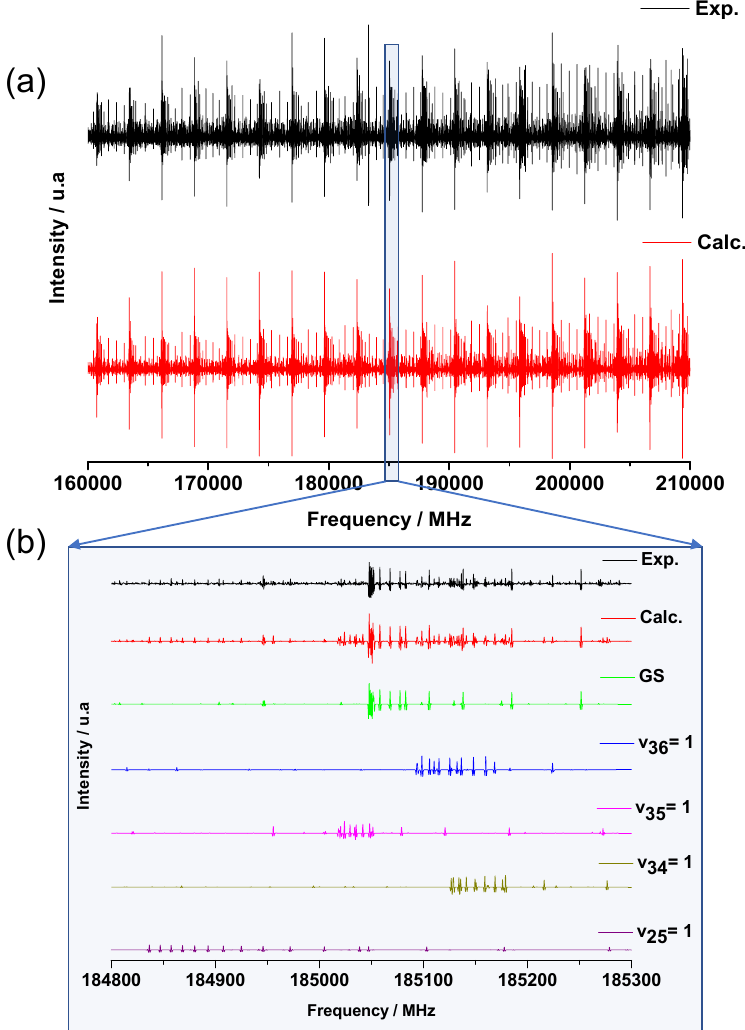
Figure 6. ( a ) Experimental (black) and calculated (red) rotational spectrum of catechol in the 160–210 GHz frequency range. ( b ) Zoom on a 500 MHz range highlighting the GS and the dif- ferent low-frequency vibrationally ES contributions to the calculated